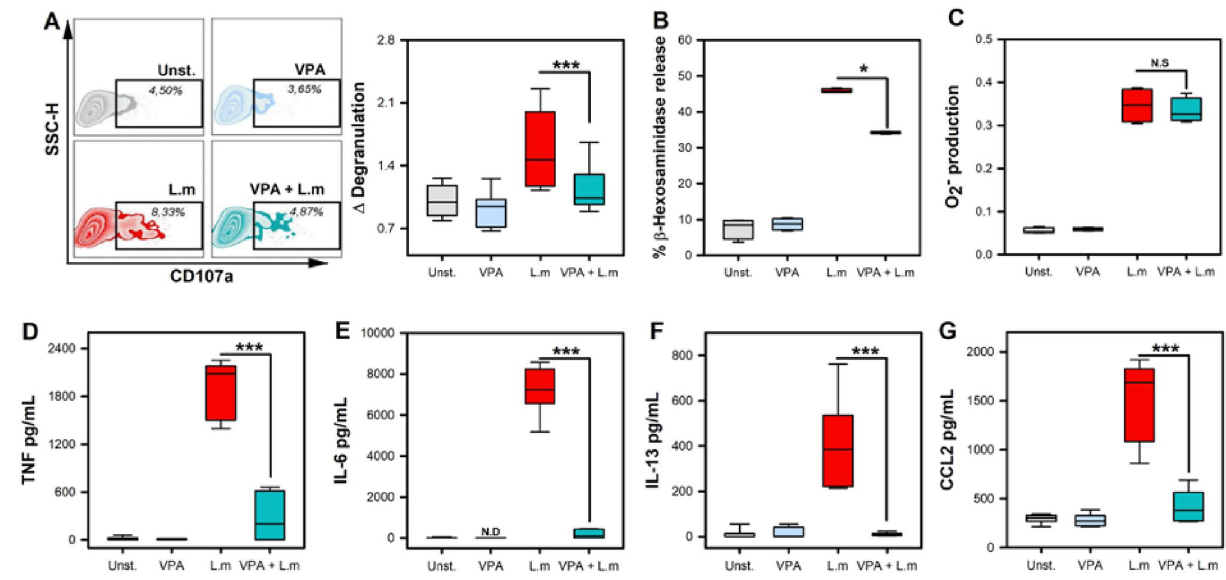
Figure 1. Valproic acid impairs mast cell degranulation and cytokine production in response to Listeria monocytogenes infection. ( A ) Bone marrow-derived mast cells (BMMC) were pre-incubated with 2 mM VPA for 18 h and then stimulated with Listeria monocytogenes (L.m) for 90 min. Degranulation was determined by flow cytometry. The left panel shows representative Zebra-plots. The right panel shows the fold change in the percentage of FcεRI + /CD107a + cells with respect to the average value of unstimulated BMMC. (n = 9 per group; *** p < 0.001; Kruskal–Wallis test). ( B ) BMMC were pre-incubated with 2 mM VPA for 18 h and then stimulated with L.m for 90 min. The MC degranulation percentage was determined by the β-hexosaminidase release assay. (n = 4 per group; * p < 0.05; Kruskal–Wallis test). ( C ) BMMC were pre-incubated with 2 mM VPA for 18 h and then stimulated with L.m for 2 h. The O 2 - evaluation was performed by the NBT reduction assay. The panel shows the fold change in the absorbance with respect to unstimulated BMMC. (n = 4 per group; N.S = Not Significance; Kruskal–Wallis test). ( D-G ) BMMC were pre-incubated with 2 mM VPA for 18 h